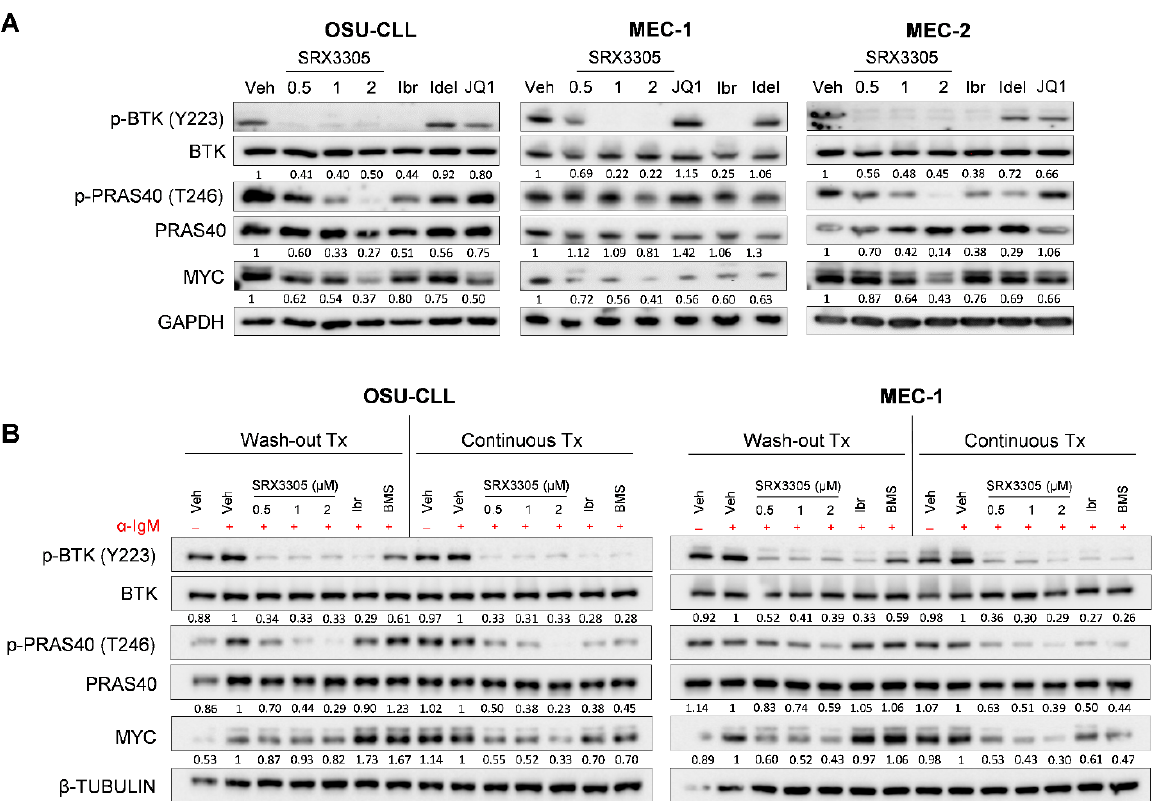
Figure 2. SRX3305 modulates critical B-cell survival pathways in CLL. ( A ) CLL cell lines (OSU-CLL, MEC-1, and MEC-2) were treated with DMSO vehicle (Veh), SRX3305 (0.5, 1, 2 µM), ibrutinib (Ibr, 1 µM), idelalisib (Idel, 1 µM), or JQ1 (0.5 µM). After 4 h, whole-cell lysates were collected and analyzed for phosphorylation and expression of the given proteins, indicative of modulation of BTK (p-BTK/BTK), PI3K (p-PRAS40/PRAS40), and BET/BRD4 (MYC). GAPDH serves as a loading control ( n = 3 independent experiments per cell line). Representative immunoblots are shown. ( B ) OSU-CLL and MEC-1 cells were treated with DMSO vehicle (Veh), SRX3305 (0.5, 1, 2 µM), 1 µM ibrutinib (Ibr; irreversible BTK inhibitor), or 1 µM BMS-986142 (BMS; reversible BTK inhibitor). Cells were either incubated with treatment continuously for 4 h (Continuous Tx), or treatment was washed out after 1 h and replaced with fresh media for the remaining 3 h of incubation (Wash-out Tx). The stimulation of BCR signaling was performed via the addition of 10 µg/mL anti-IgM for the last 15 min (+ ɑ -IgM). Whole-cell lysates were then analyzed for expression or phosphorylation of the indicated proteins ( n = 3 independent experiments per cell line). β -Tubulin serves as a loading control. Representative immunoblots are shown for each cell line. Numbers below the bands represent densitometric quantification relative to loading control, total protein (for phosphorylated proteins), and normalized to Veh (for ( A )) or + α -IgM Veh (for ( B )).